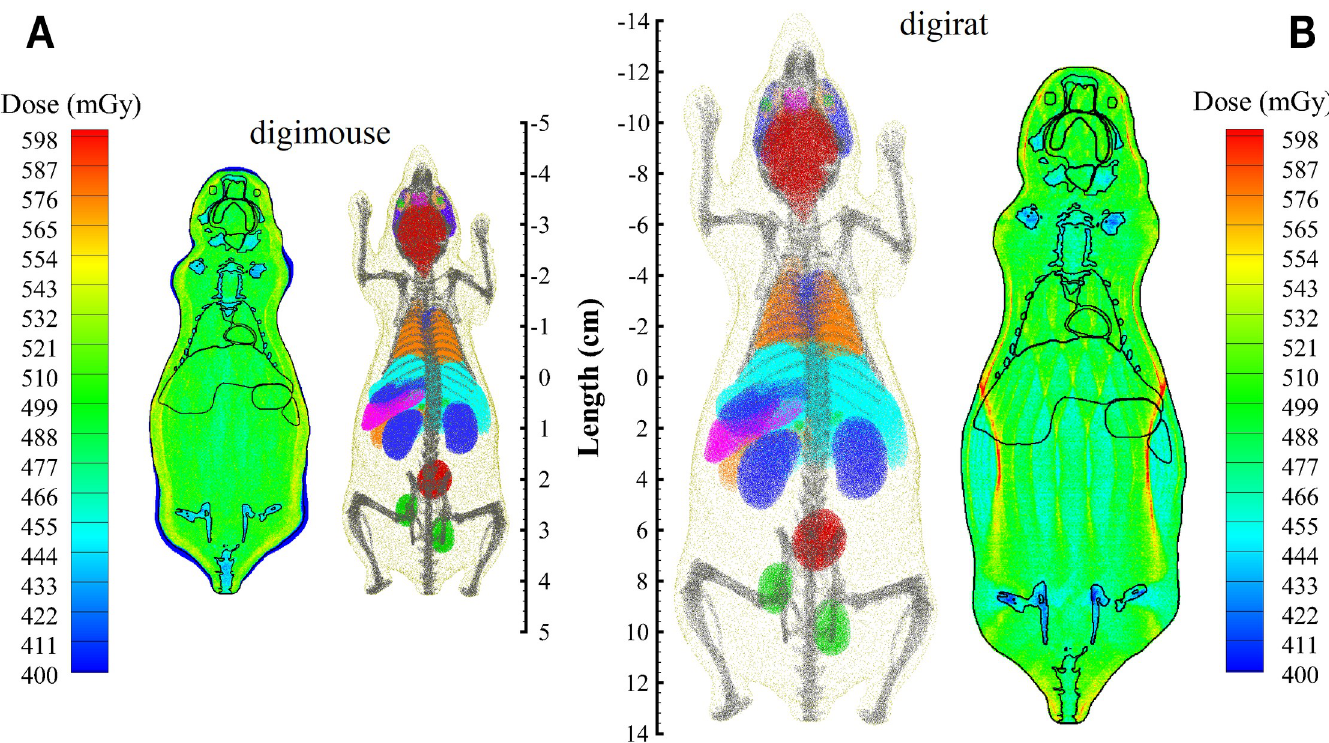
Fig 9. Mouse and rat voxel models used to evaluate dose distributions in tissues from exposure to GCR simulation. Digimouse (A) has been scaled by a factor of 3.15 to obtain and estimate of a rat’s body self-shielding, referred to here as “digirat” (B). Transport of full GCR simulation field provides homogeneous dose distribution within voxel mouse model (A) and scaled rat model (B). GCR, galactic cosmic radiation.